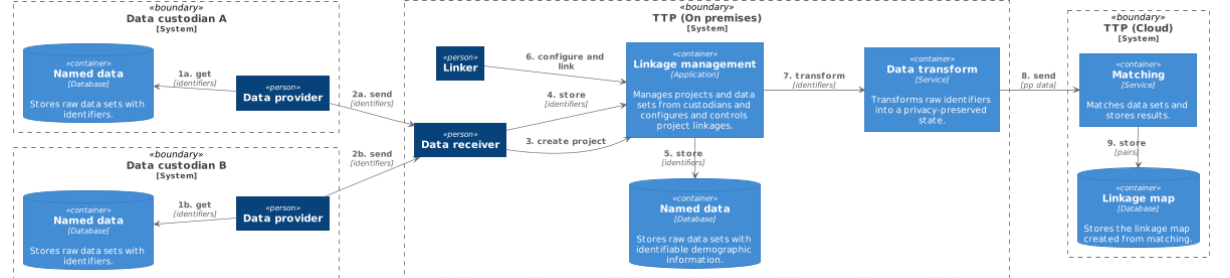
Keeping identifiers at the data custodian level (on-premises)